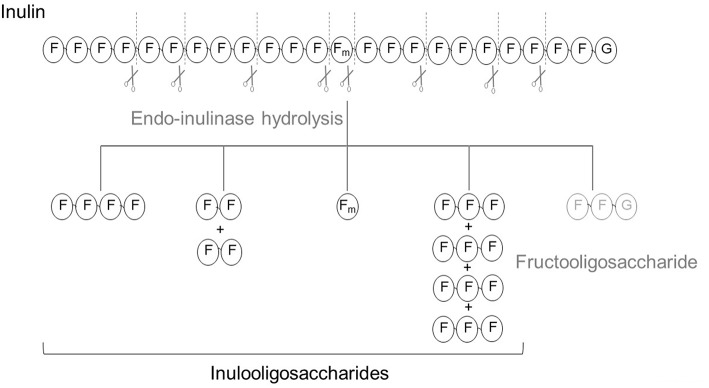
Scheme of the hydrolysis of inulin using endo-inulinase as biocatalyst. Each initial GFn yields one fructooligosaccharide and several inulo-oligosaccharides.